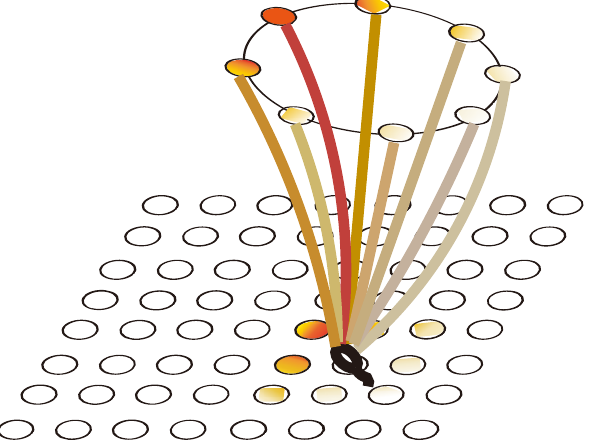
Figure 8. The mapping relationships between cognitive maps and action neurons. Among them, Q and R represent the action value function and reward function, respectively, a (cid:48) represents any action in the action set, and F i ( r t ) is the position cell filter, as shown in Equation